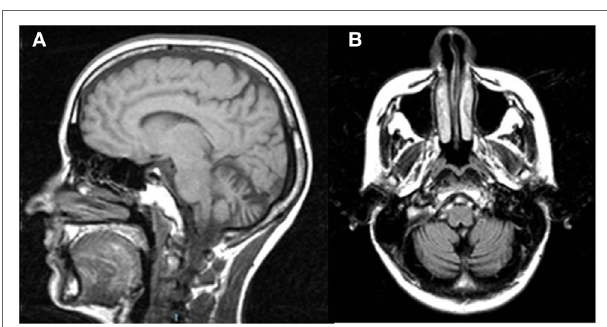
FigUre 1 | Sagittal T1w (a) and coronal T2w-FLAIR (B) magnetic resonance images of Patient 2 show vermian and hemispheric cerebellar atrophy.